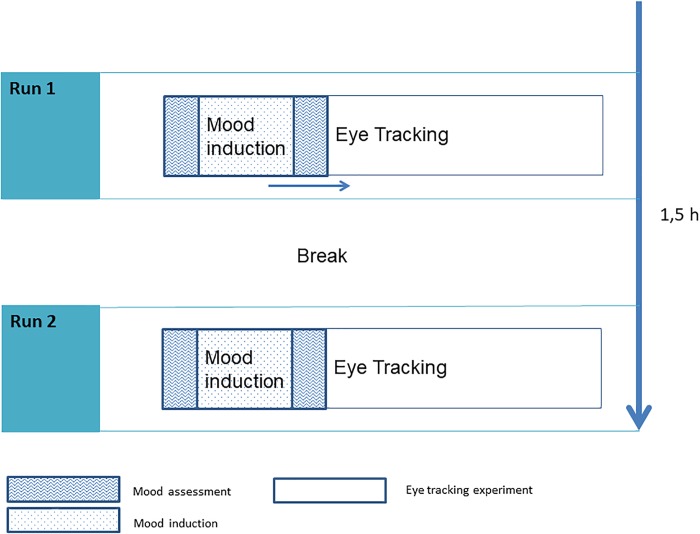
Experimental design.